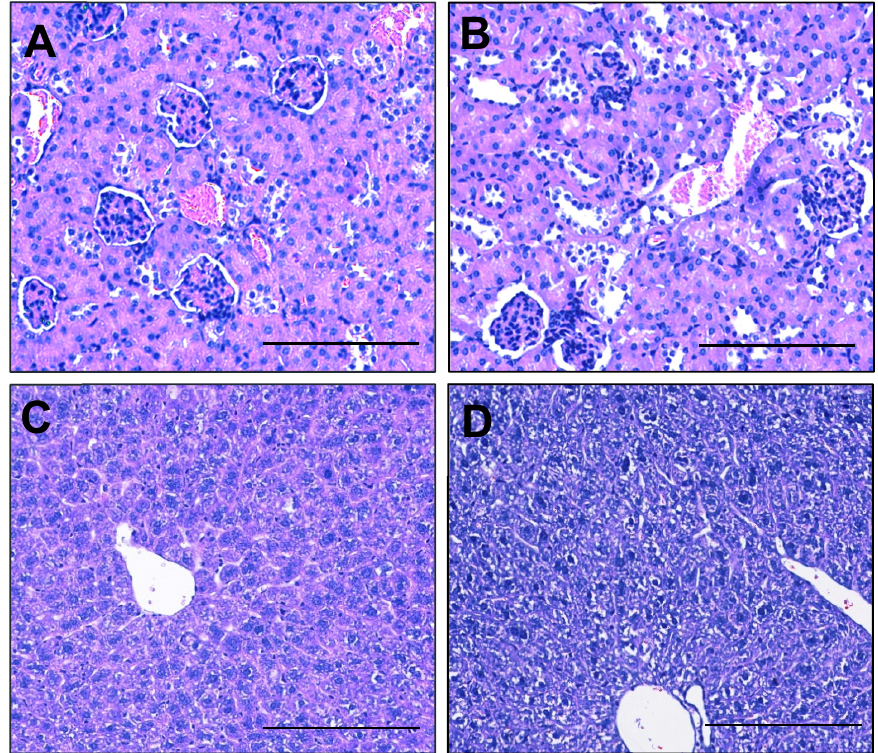
Figure 5. Esomeprazole does not alter kidney or liver morphology of lean pregnant mice receiving L-NAME. Haematoxylin- and eosin-stained sections of kidney did not show differences in glomeruli, Bowmen’s capsule, or immune infiltrations between the ( A ) control and ( B ) esomeprazole group. Assessment of liver showed no difference in micro/macro vesicular steatosis, nuclear displacement, or fibrosis between the ( C ) control and ( D ) esomeprazole group. Scale bar = 100 µm.